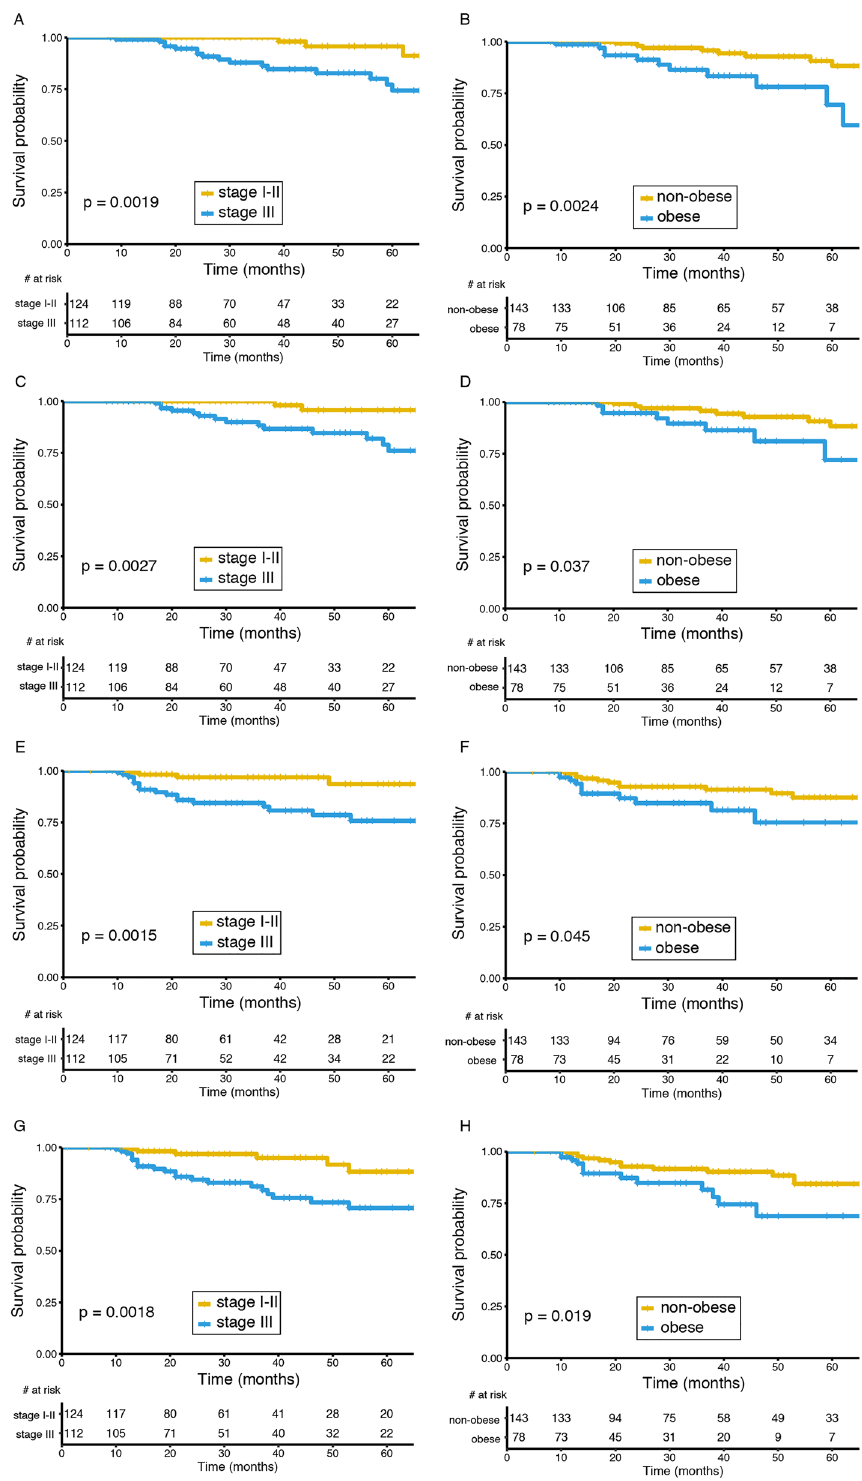
Figure 1. Stage at diagnosis and BMI status affect survival rates in patients that achieved pathological complete response after neoadjuvant chemotherapy. ( A ) Overall survival (OS) curves comparing stage I/II versus stage III (LogRank p = 0.0019). ( B ) OS curves comparing non-obese versus obese (LogRank p = 0.0024). ( C ) Breast cancer specific survival (BCSS) curves comparing stage I/II versus stage III (LogRank p = 0.0027). ( D ) BCSS curves comparing non-obese versus obese (LogRank p = 0.037). E. Distant disease-free survival (DDFS) curves comparing stage I/II versus stage III (LogRank p = 0.0015). ( F ) DDFS curves comparing non-obese versus obese (LogRank p = 0.045). ( G ) Invasive-disease free survival (IDFS) curves comparing stage I/II versus stage III (LogRank p = 0.0018). ( H ) IDFS curves comparing non-obese versus obese (LogRank p =